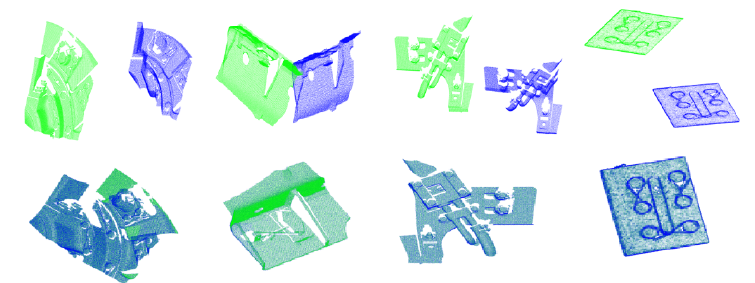
Figure 15. Results of 3D surface matching on real data. The up column is the initial position of these components. The down column is the results of 3D surface